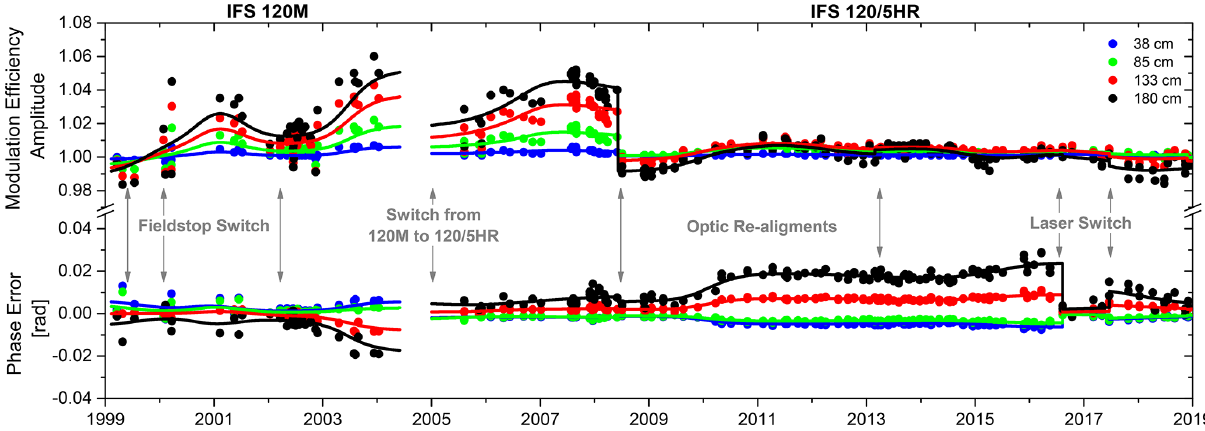
Figure 1. Time series of the normalised modulation efficiency amplitude (MEA) and phase error (PE, rad) at four optical path differences (33, 85, 133, and 180cm) for the NDACC O 3 measurement settings (filter 6 and MCT detector) of the IZO FTIR spectrometers between 1999 and 2018. Data points represent individual N 2 O-cell measurements and solid lines depict smoothed MEA and PE curves. Solid grey arrows indicate punctual interventions for the instruments: different changes of field stops between 1999 and 2004, the switch from the IFS 120M to the IFS 120/5HR system in 2005, optic re-alignments in June 2008 and February 2013, and internal laser replacements in August 2016 and June